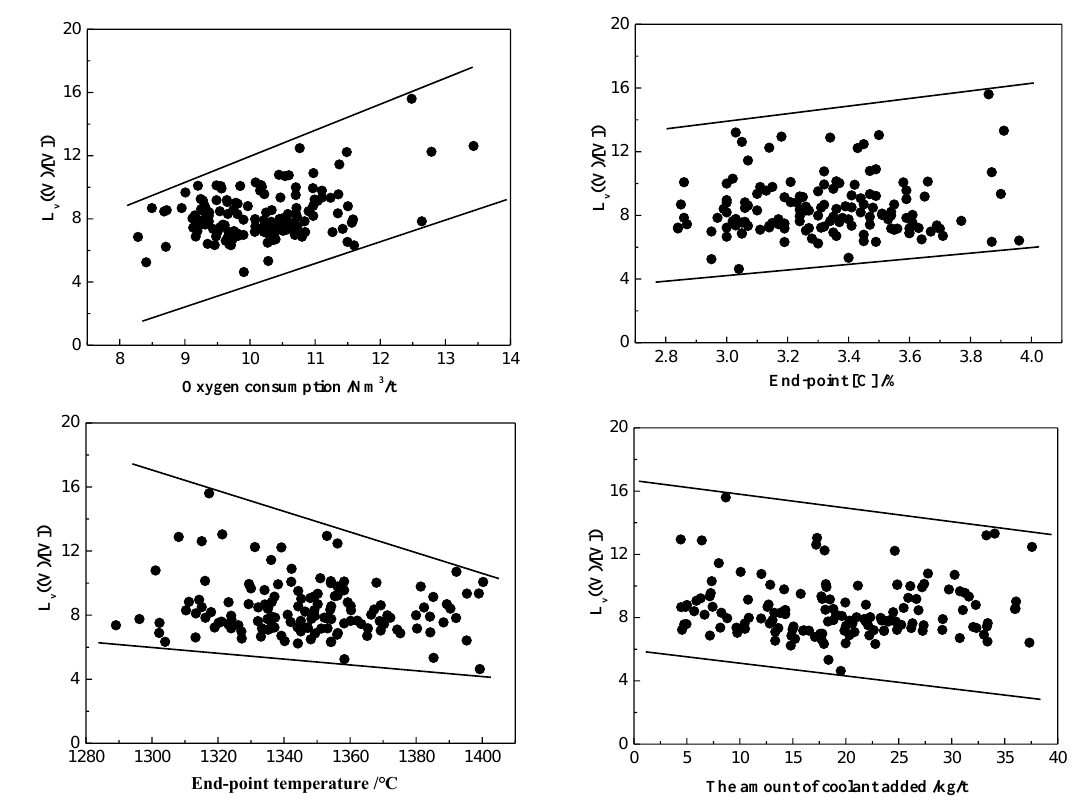
Figure 8. Factors affecting the distribution ratio of vanadium.